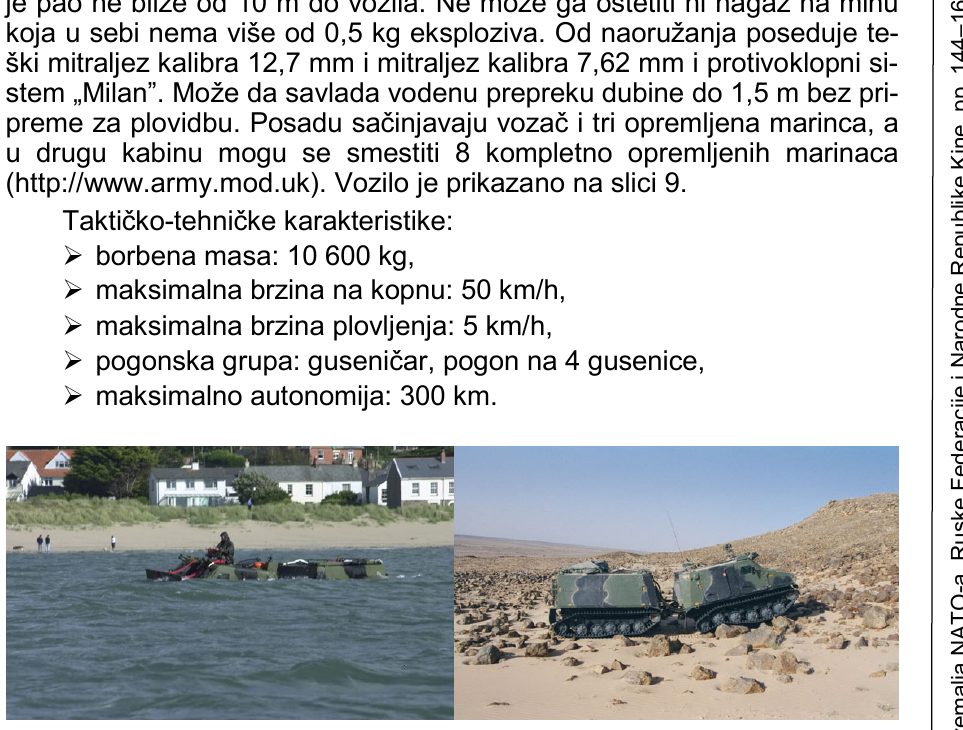
Figure 9 – UK amphibious armoured all-terrain vehicle „Viking” (BVS10) Lebdelice oružanih snaga